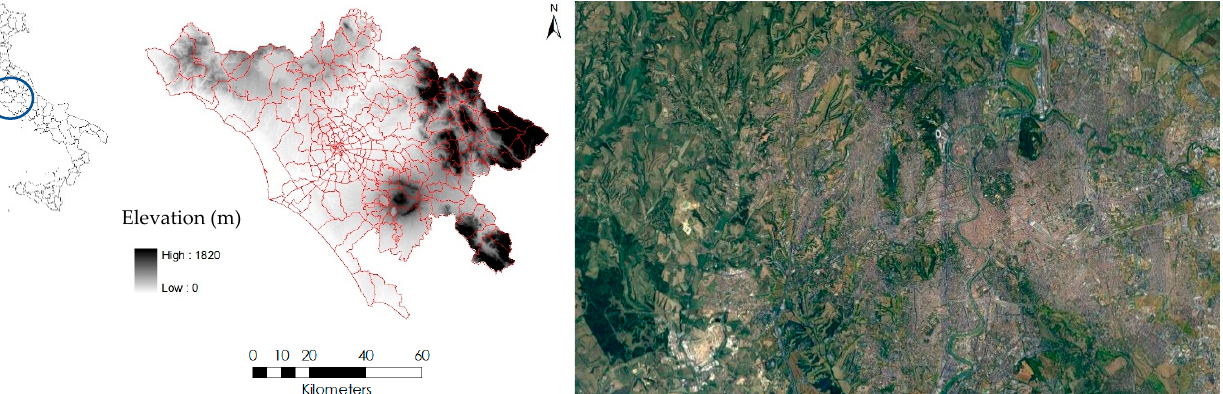
Figure 2. Left : elevation of the study area (meters on the sea level) overlapped with municipalities and urban districts; the insert map represents the position of Rome in Italy; right : a zenith photograph of inner Rome with peri-urban forests (green areas) concentrating on the left side of the landscape scene, courtesy of Google Earth.